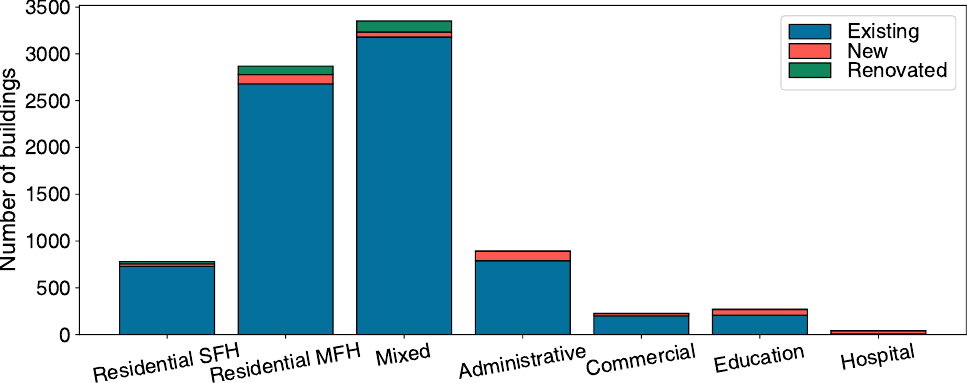
Figure 7. Refurbishment level building distribution in Geneva city center.